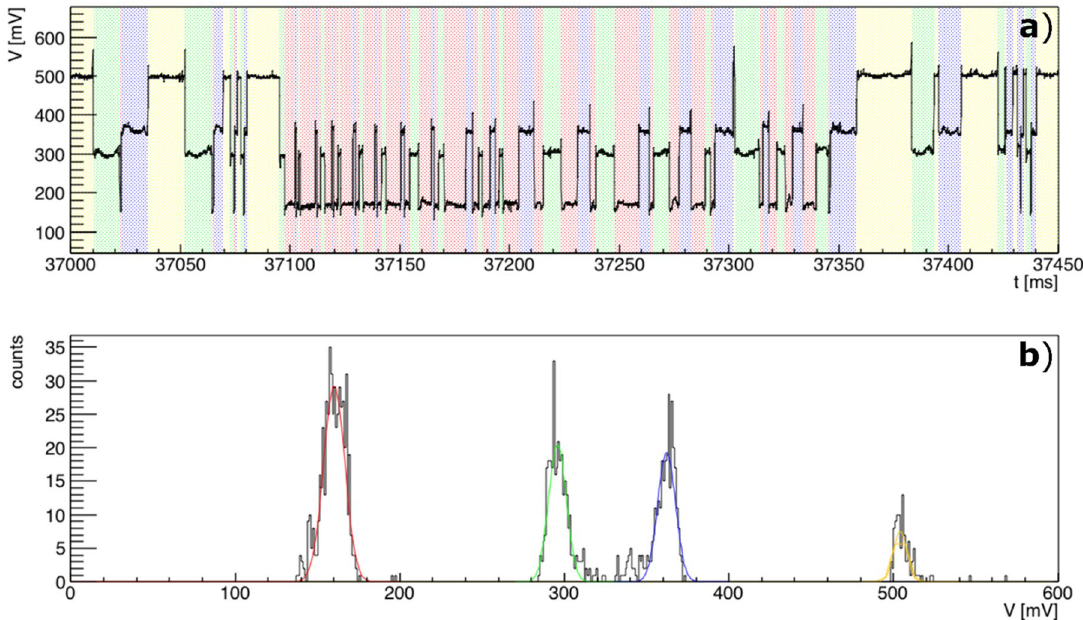
Figure 6. Labelling of a random and unknown sequence of droplets. ( a ): OT signal detected by the MZI during the flow of the 25 droplets, each of which is sequenced distinguishing each interval using colored boxes. The labelling evidenced four classes of OT signal data characterized by the histograms in ( b ), where each four time are fitted with gaussian function with corresponding color. The centroids of the gaussian are: 160 ± 0.3, 295.8 ± 0.4, 362 ± 0.4, 504 ± 0.6 mV and the standard deviation are: 6.5 ± 0.3, 5.4 ± 0.3, 5.4 ± 0.4, 4.0 ± 0.9 mV. Flowrate of the dispersed phase Q d Flowrate of the continuous phase Q c (µL/min) (µL/min) Length range (μm) Velocity range (μm/min) Label of the Number of emulsions